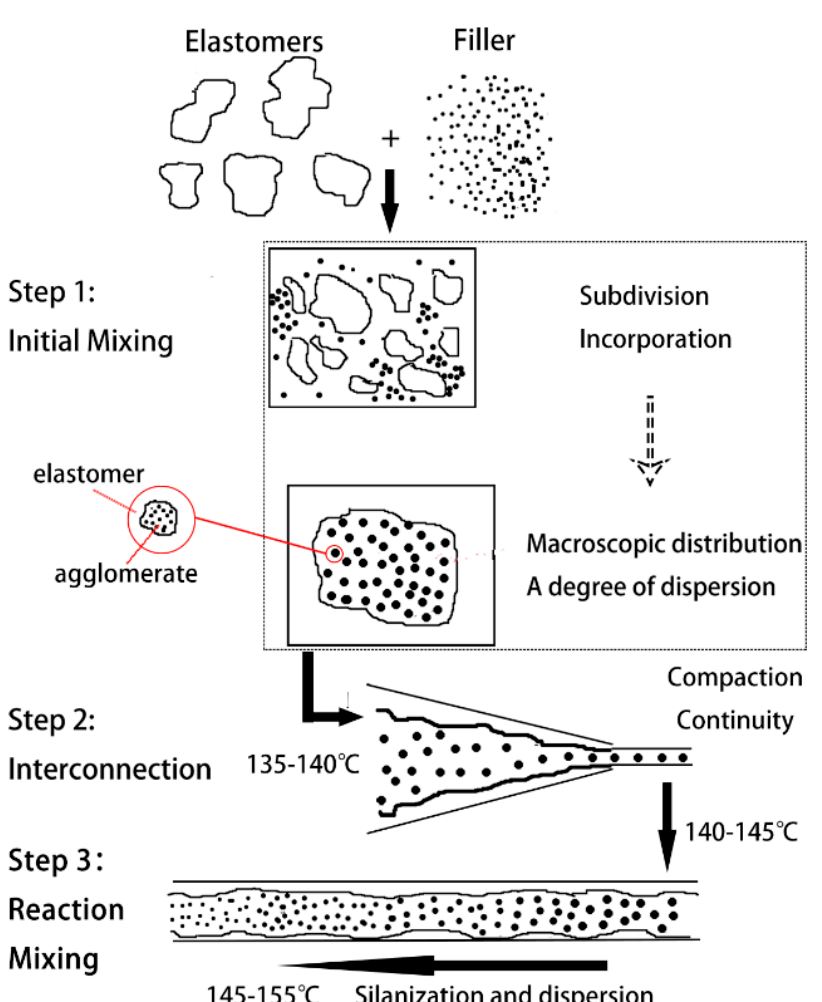
Figure 6. Mixing mechanism and process of serial modular continuous mixing.